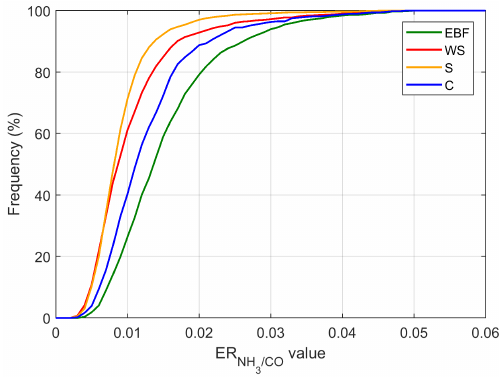
Figure 5. Cumulative curve of the yearly ER NH lated between 2008 and 2015 for the pixels selected in Sect. 2.3 separated by